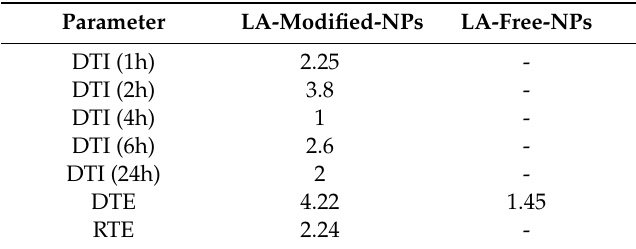
Table 5. Hepatic specific delivery parameters of 99m Tc-BA-loaded-LA-modified-CL-NPs relative to 99m Tc-BA-loaded-LA-free-CL-NPs following oral administration in mice.